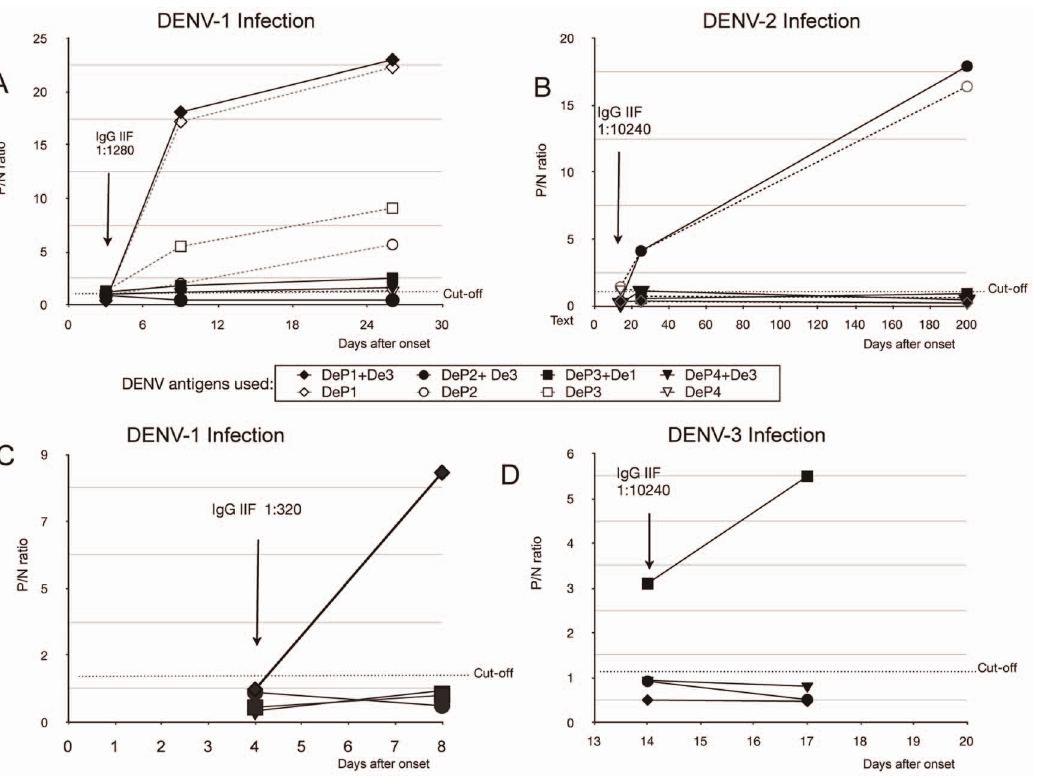
Figure 4. Antibody kinetics of four patients with DENV-1, -2 or -3 infection. A . Samples of DENV-1 infected patient collected on days 3, 9 and 26 after onset. B . Samples of a DENV-2 infected patient, collected on days 14, 25 and 200. C. D . Samples of a DENV-1 and a DENV-3 infected patient. ICB ELISAs were performed with competition (filled symbols) and without competition (open symbols) by De antigens. Initial IIF titers are